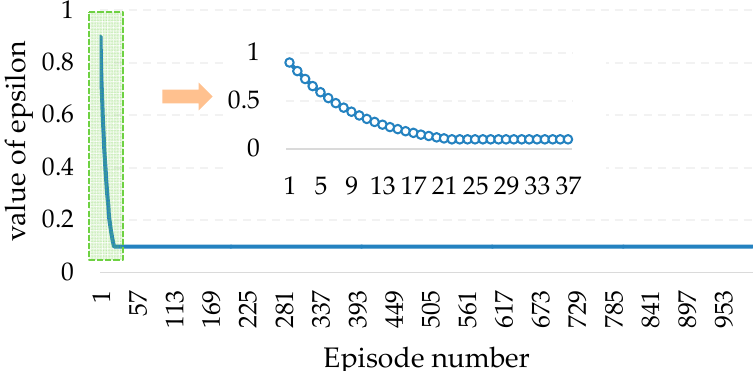
Figure 11. The value of epsilon during learning time.